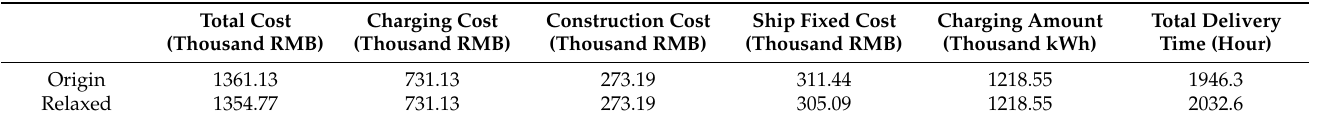
Table 12. Impact of service time limit of transportation